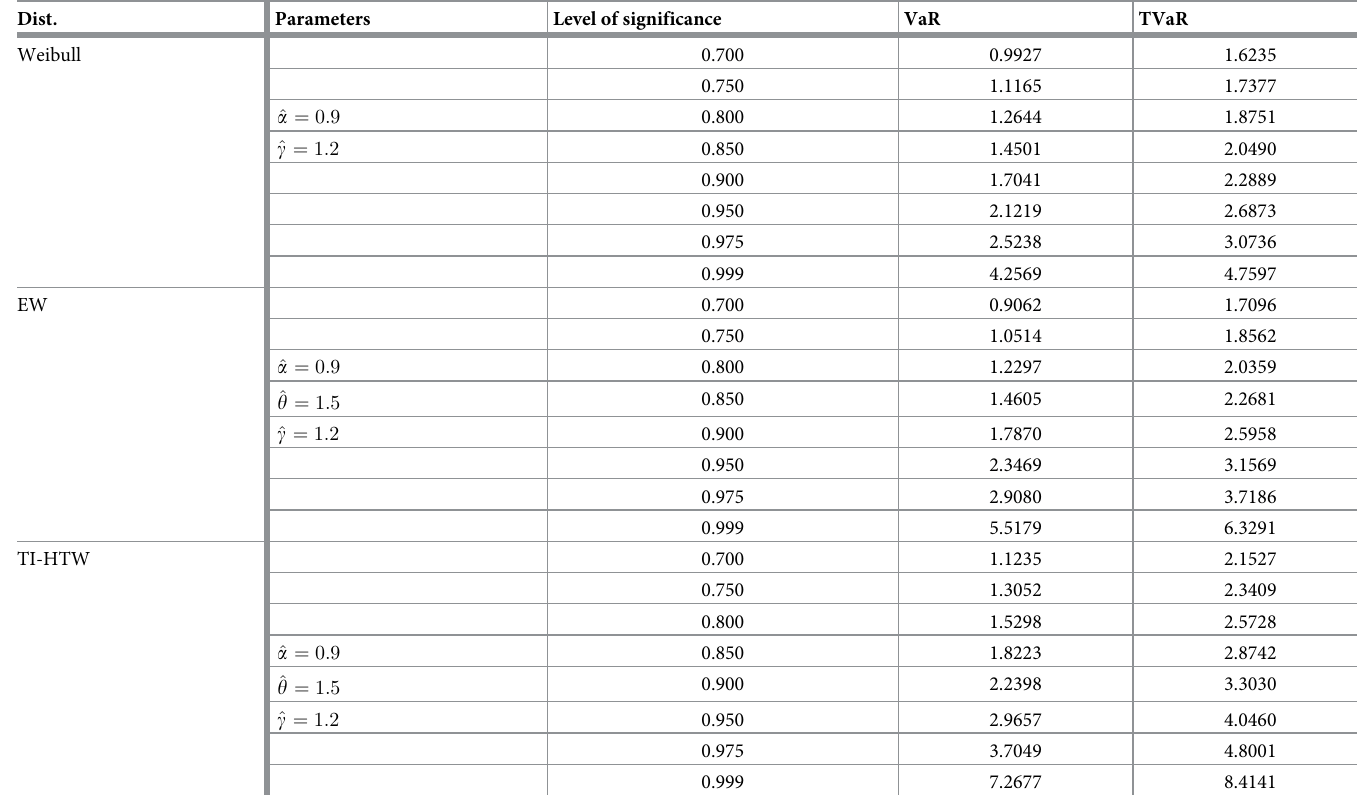
Table 6. Simulation results for VaR and TVaR of the fWeibull, EW and TI-HLW distributions.